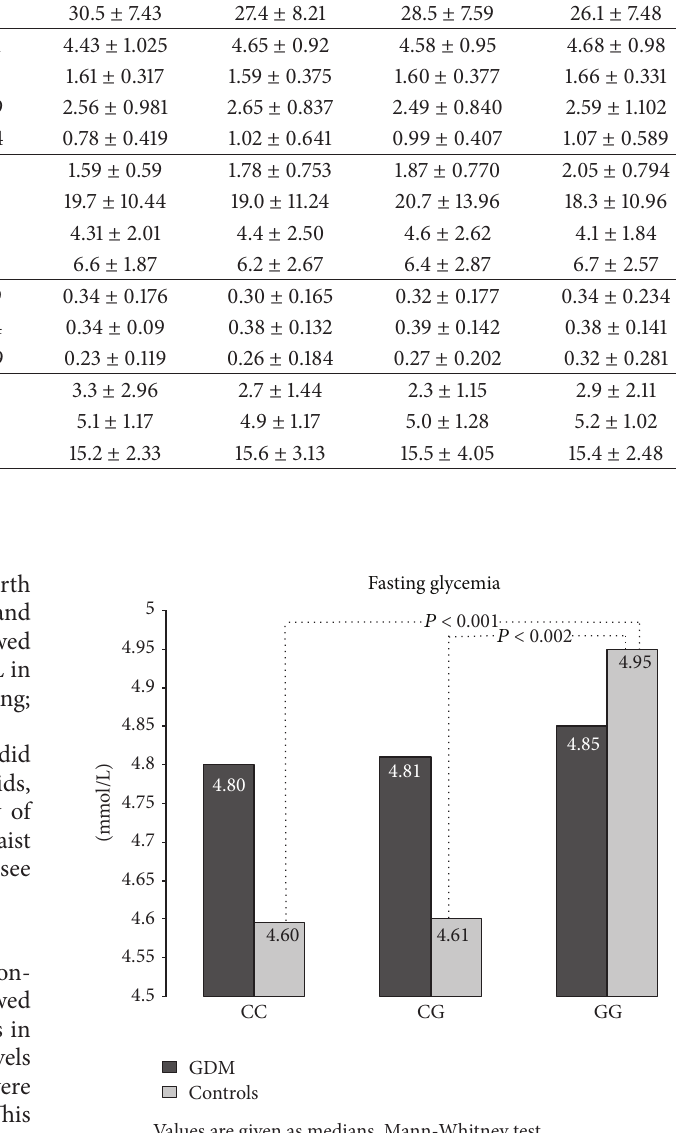
Figure 1: Fasting glycemia based on the MTNR1B SNP rs10830963 genotypes.